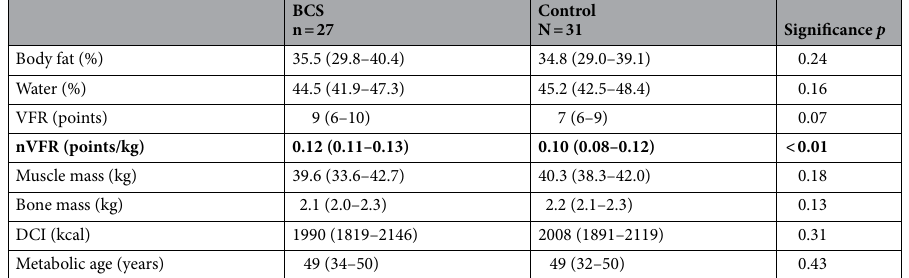
Table 3. Comparison of body composition measures between Breast Cancer Survivors (BCS) and control groups. VFR visceral fat rating, nVFR normalized visceral fat rating, DCI daily caloric intake. Data as presented as median (25th, 75th percentiles). Mann–Whitney’s U tests between BCS and control groups. Bold values correspond to significant results ( p value <